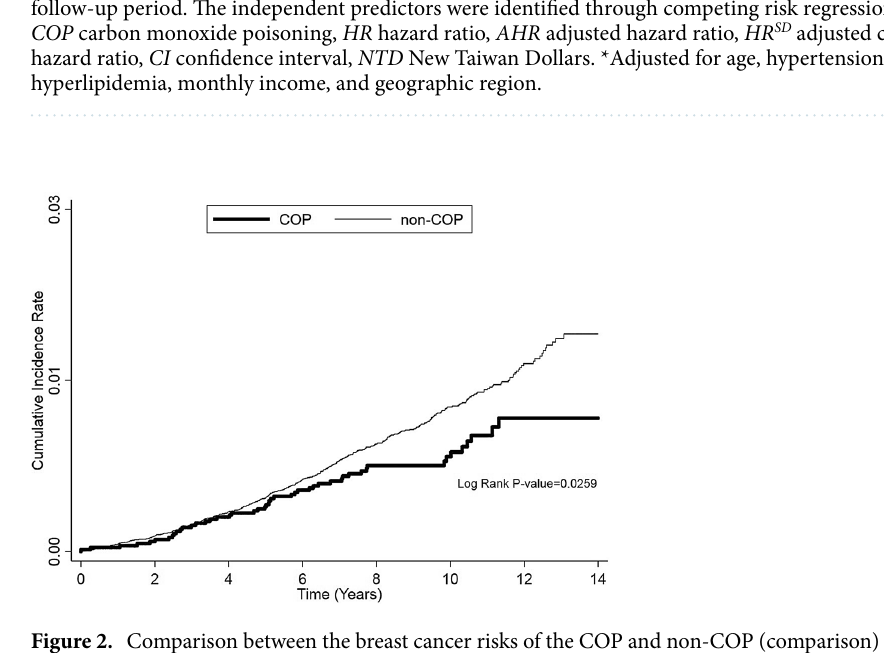
Figure 2. Comparison between the breast cancer risks of the COP and non-COP (comparison) cohorts during follow-up. The comparison was performed through the Kaplan–Meier’s method and the log-rank test. COP, carbon monoxide